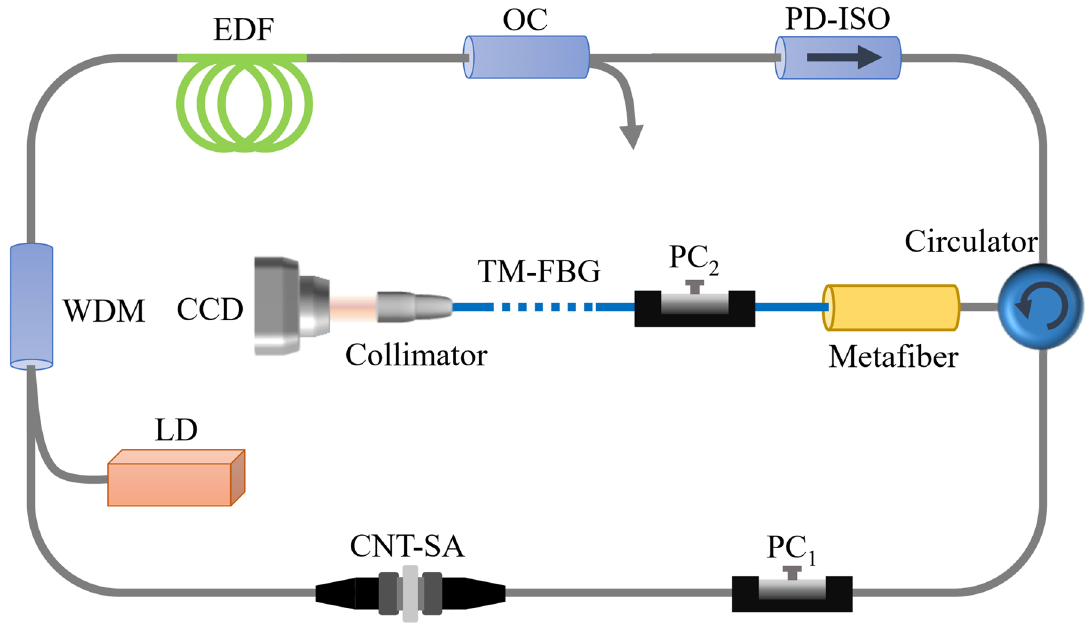
Figure 4: Experimental setup of all-fiber Q -switched CVB laser with the plasmonic metafiber. LD, laser diode; WDM, wavelength division multiplexer; EDF, erbium-doped fiber; PC, polarization controller; OC, output coupler; PD-ISO, polarization-dependent isolator; CNT-SA, carbon nanotube saturable absorber; CCD, charge-coupled device. The gray and blue lines represent SMF and TMF,